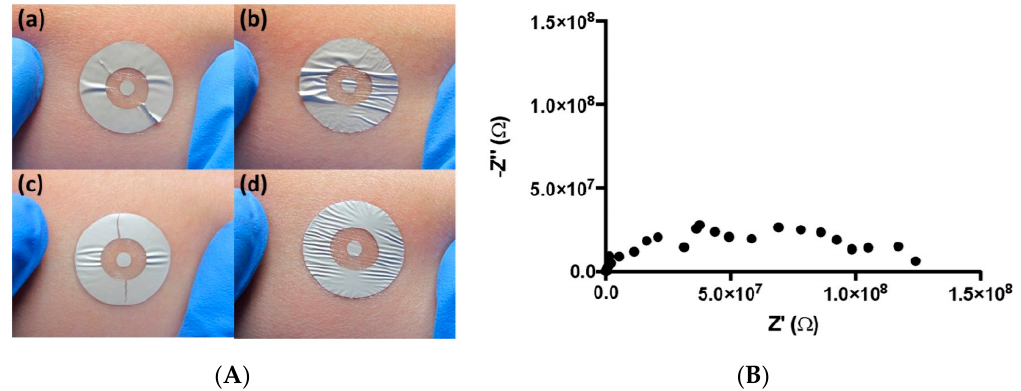
Figure 35. ( A ) Images of the thin flexible device upon stretching on skin, for (a) silver electrodes only, (b) silver + elastomer, (c) silver electrodes + porous acrylate adhesive and (d) silver + elastomer electrodes + porous acrylate adhesive. ( B ) Impedance (Nyquist plot) of the inner forearm, measured by the silver-elastomer tattoo device. Reproduced from [99] with permission from The Royal Society of Chemistry.